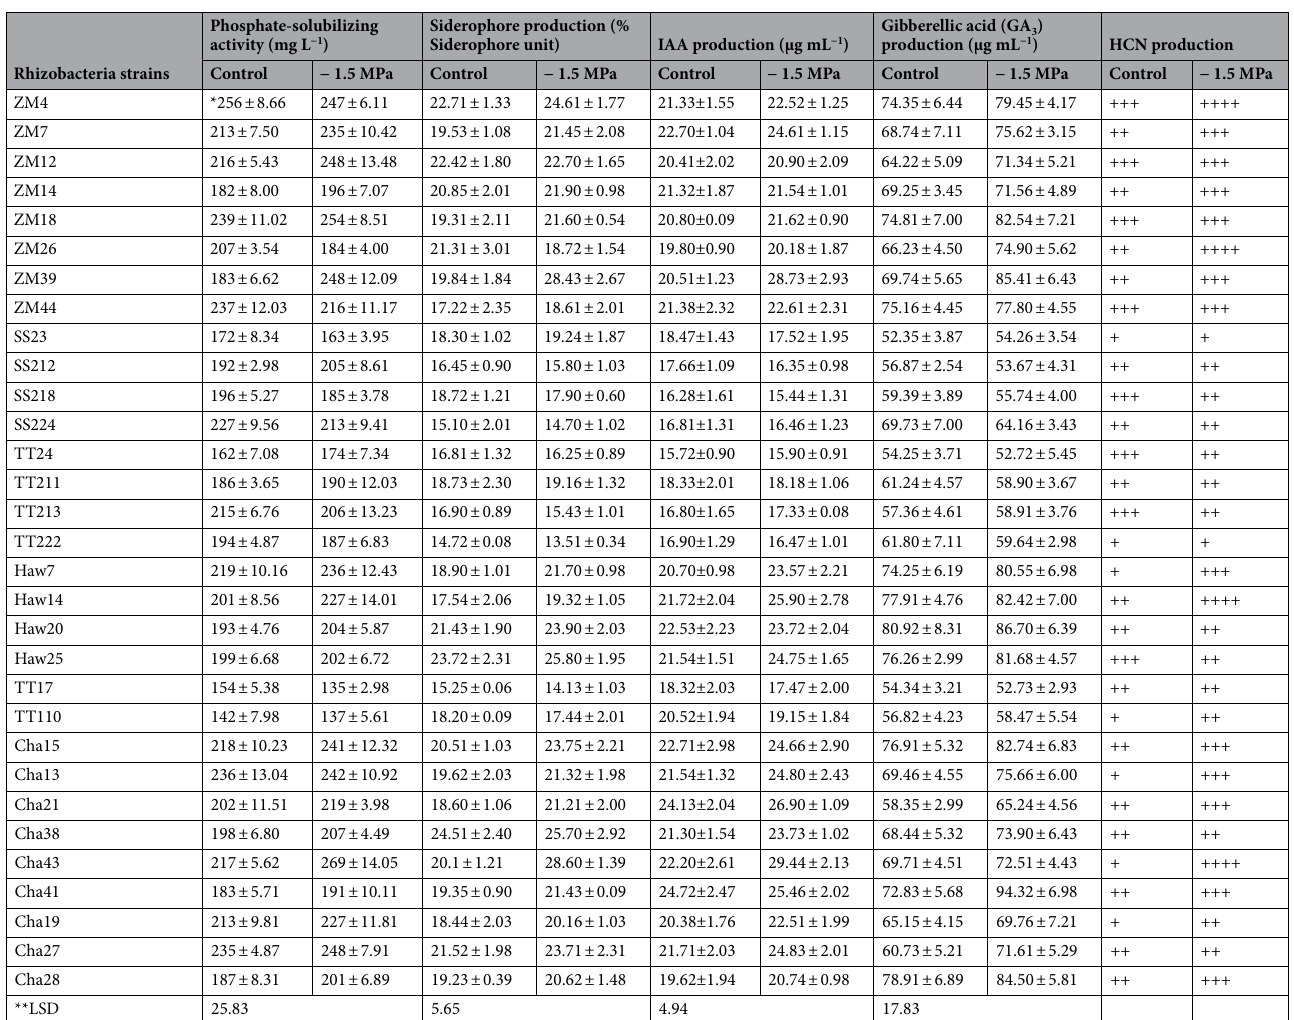
Table 3. Multiple plant growth promoting activities of the promising rhizobacterial strains, isolated from different rhizospheres of walnut trees, under control (0 MPa) and PEG 6000 -induced drought stress (− 1.5 MPa) treatment. *Value represent mean ± SEM; ** Least Significant Difference (LSD; p < 0.001) for mean comparison of strain-drought interaction effects.